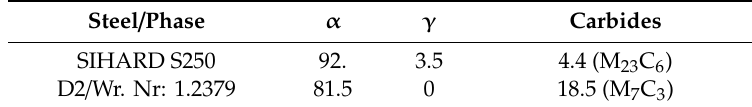
Table 2. Phase fractions of SIHARD S250 and AISI D2 steel in the hardened condition. Steel / Phase